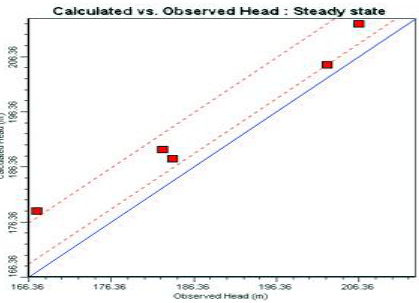
Figure-3 Comparison of calculated and observed well head Contamination migration: General migration